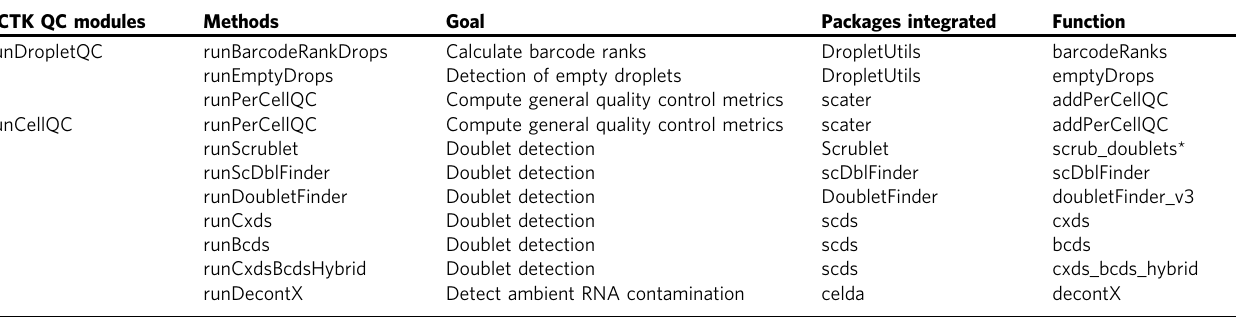
The diverse algorithms and their corresponding SCTK-QC wrapper functions that are used to generate quality control QC metrics in SCTK-QC pipeline. The asterisk denotes Python